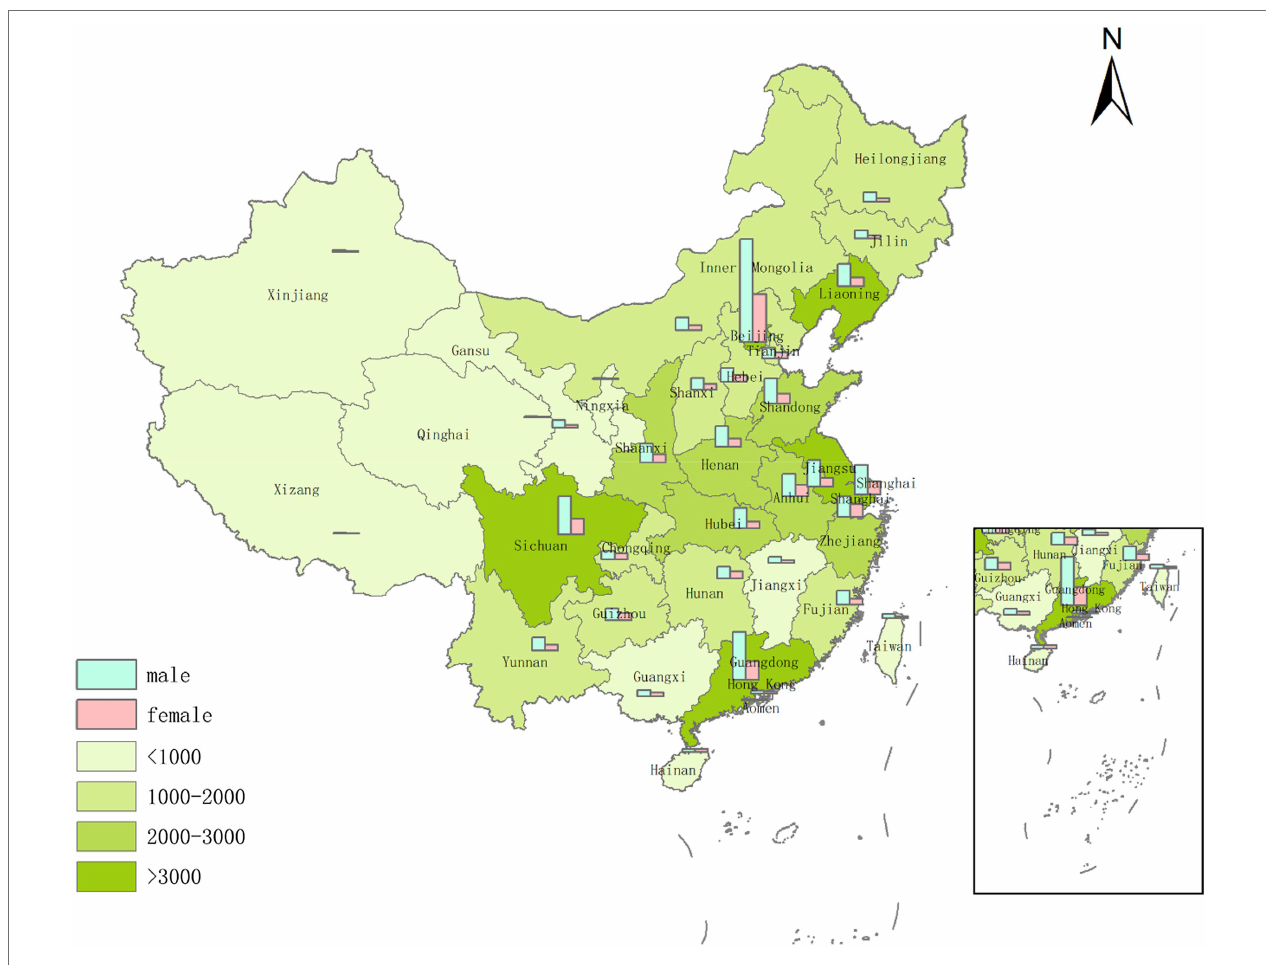
FIGURE 4 | Gender and regional distribution of users participating in the ASF-related